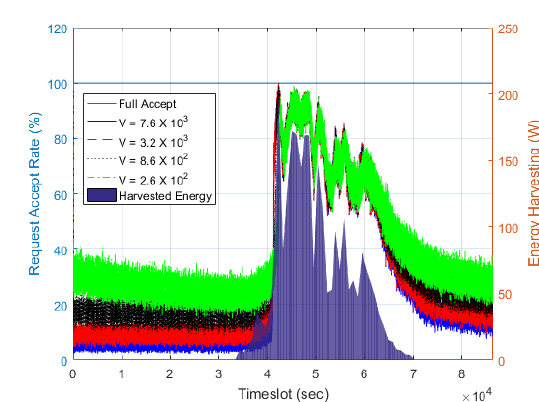
Figure 5. Request accept rate vs.